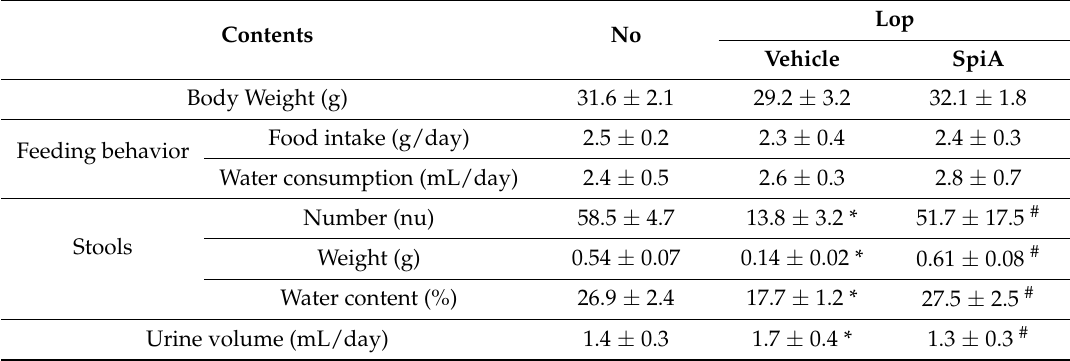
Table 1. Measurement of body weight, feeding behavior, stools and urine secretion in Lop-induced constipated ICR